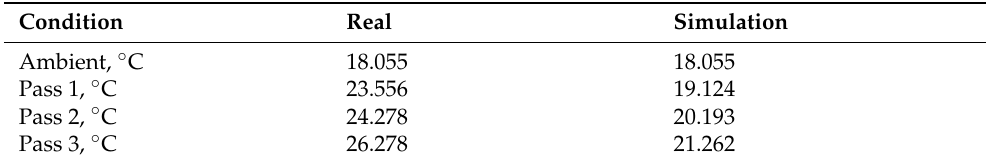
Table 2. Real Workpiece vs. Simulation